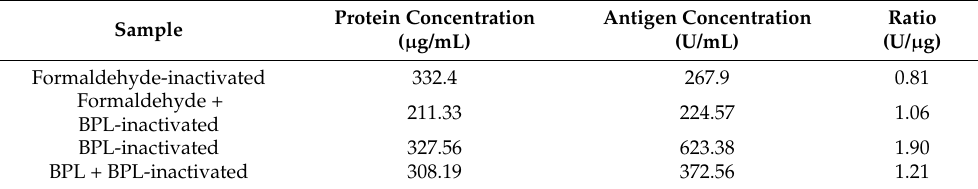
Figure 5. SDS-PAGE and western blot analyses of inactivated virus samples. ( A ) SDS-PAGE of inactivated virus samples, ( B ) Western blot analyses of inactivated virus samples. M: protein ladder; 1: formaldehyde-inactivated; 2: formaldehyde + BPL-inactivated; 3: BPL-inactivated; 4: BPL + BPL-inactivated. Table 3. ELISA analysis of protein and antigen concentrations of different inactivated virus sam ‐ ples.